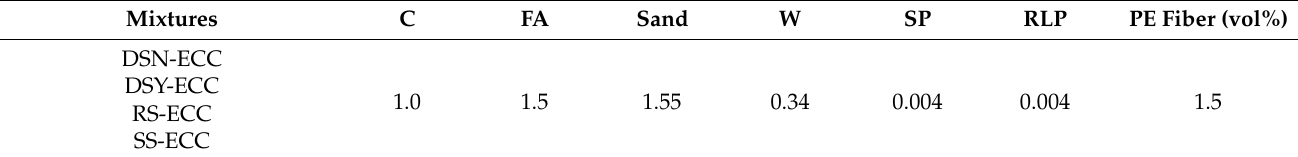
Table 3. Mix proportion (by weight ratio) used in the